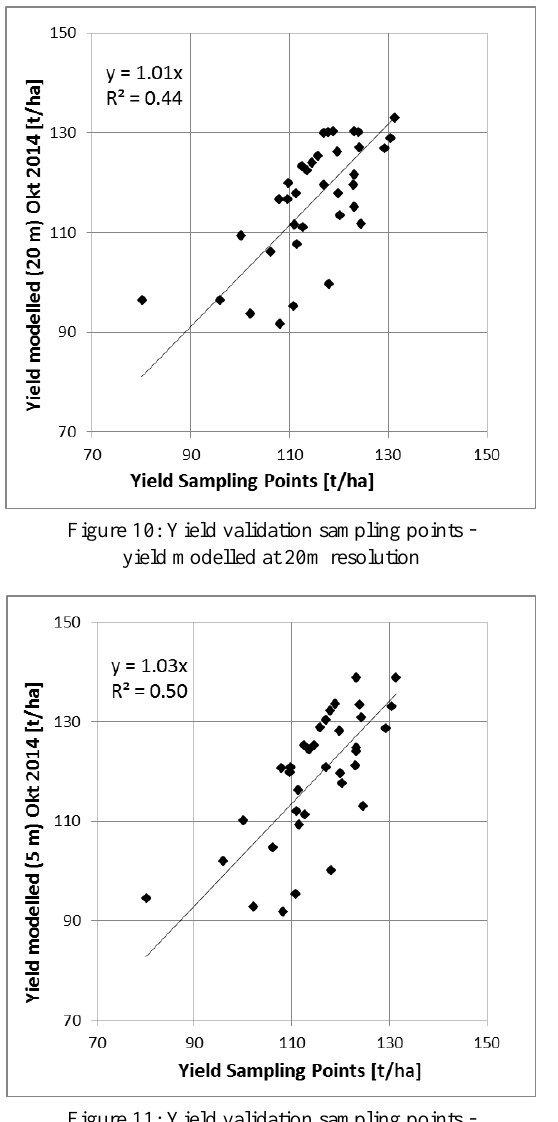
Figure 11: Yield validation sampling points - yield modelled in 5 m